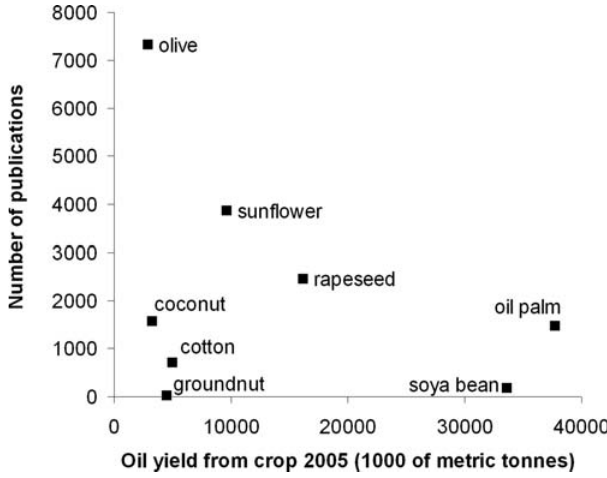
Figure 3. Oil yield from top eight crops in 2005 [ 2 ] in relation to total number of publications on each crop. Publication frequency between 1970 and 2006 was assessed using Web of Science [7].